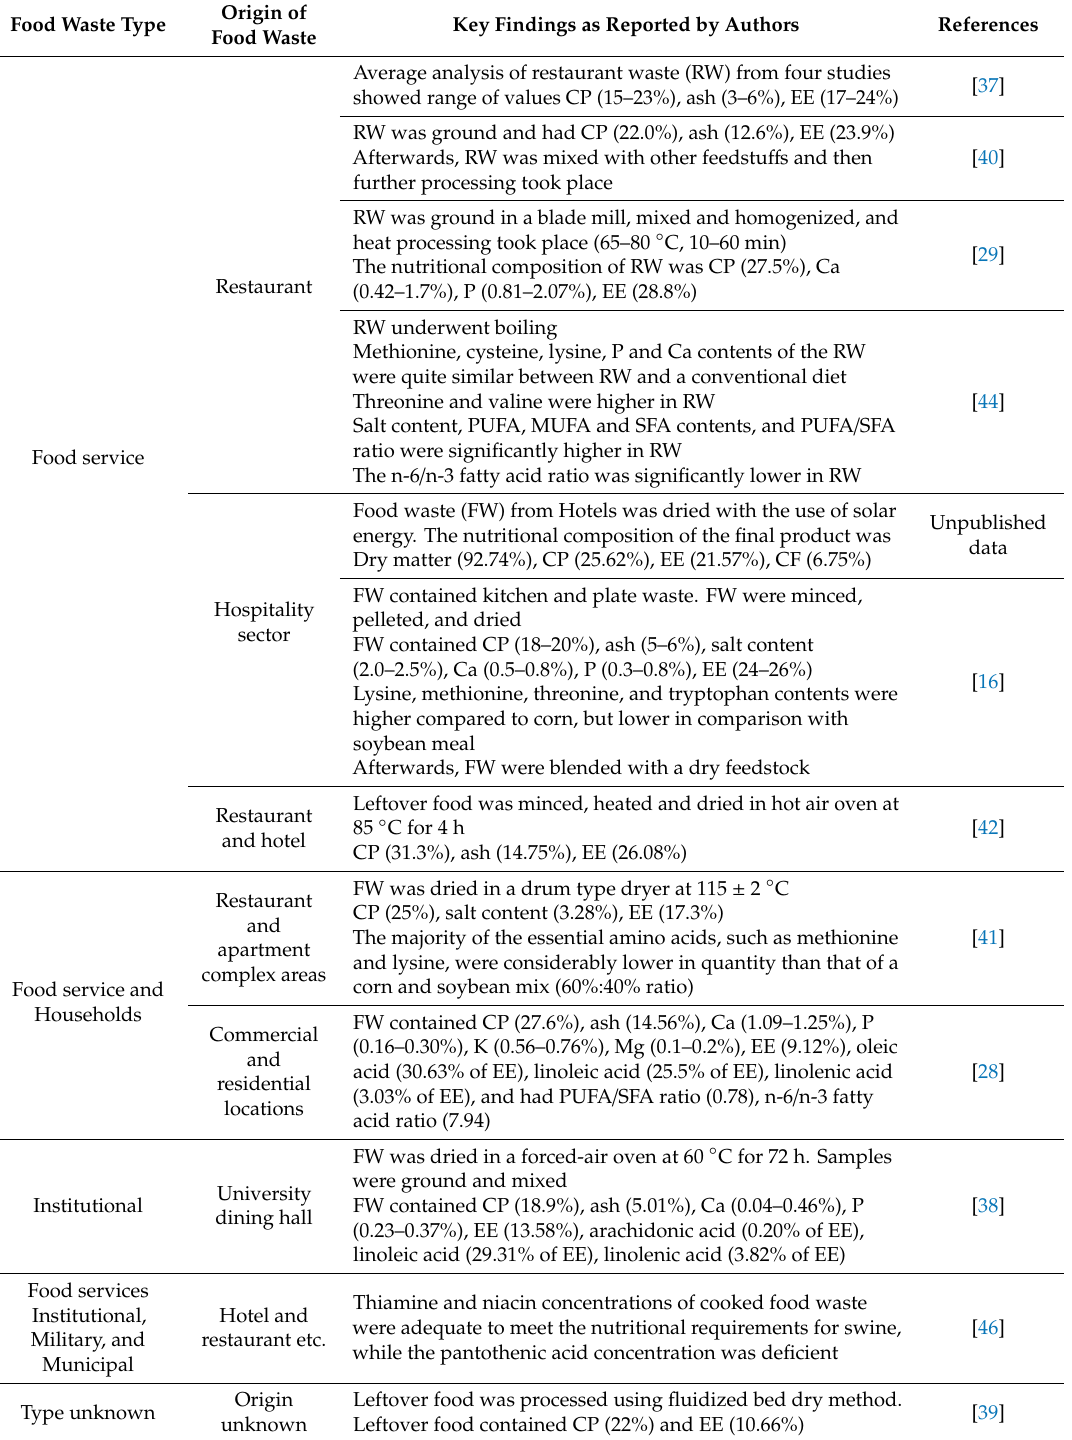
Table 1. A summary of selected studies reporting bioactive compounds and major components of food